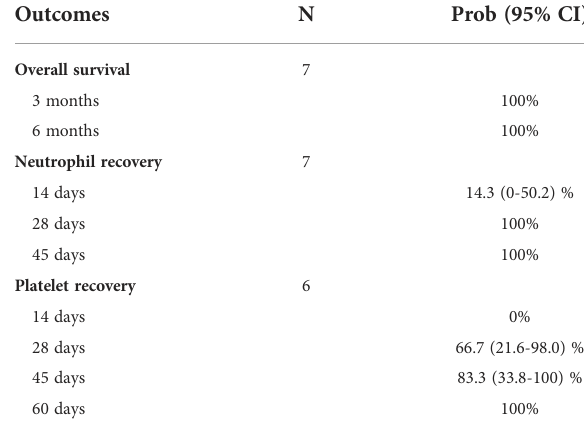
TABLE 5 Characteristics of hematopoietic stem cell transplant (HCT) recipients from donors that tested positive for COVID-19 post-